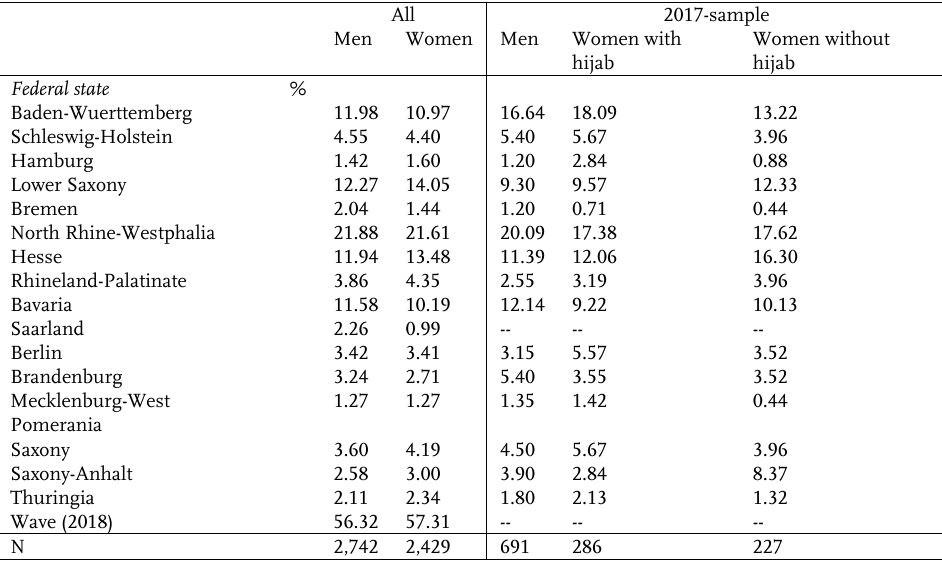
Table A.1 : Descriptive statistics, imputed data